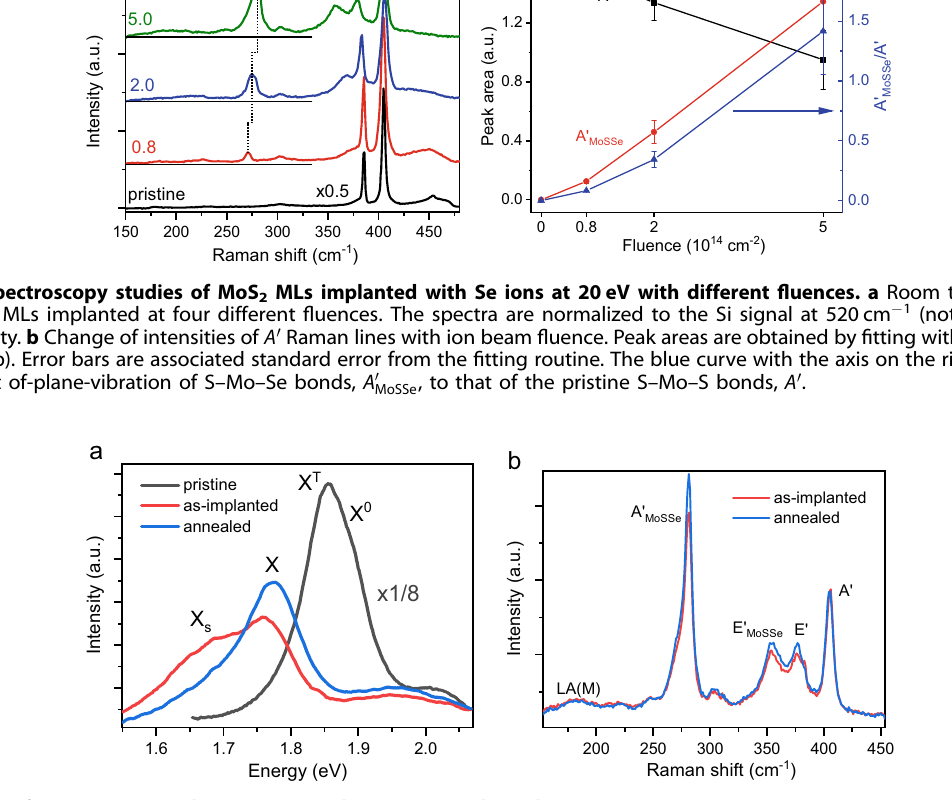
Fig. 6 The effect of ex-situ post-implantation annealing on Se-implanted MoS 2 ML. a Room temperature PL spectrum from as-implanted ML (red line) shows a broadband emission comprising of two peaks X s and X. The one at lower energy X s is removed by post-implantation ex- situ annealing at 200 ° C (blue line). The remaining higher energy peak X is red-shifted compared to the X T emission line from the measurement before implantation (black line). b Room temperature Raman spectra, which are normalized to A ′ peak (of MoS 2 ) to compare the intensities of A 0 MoSSe